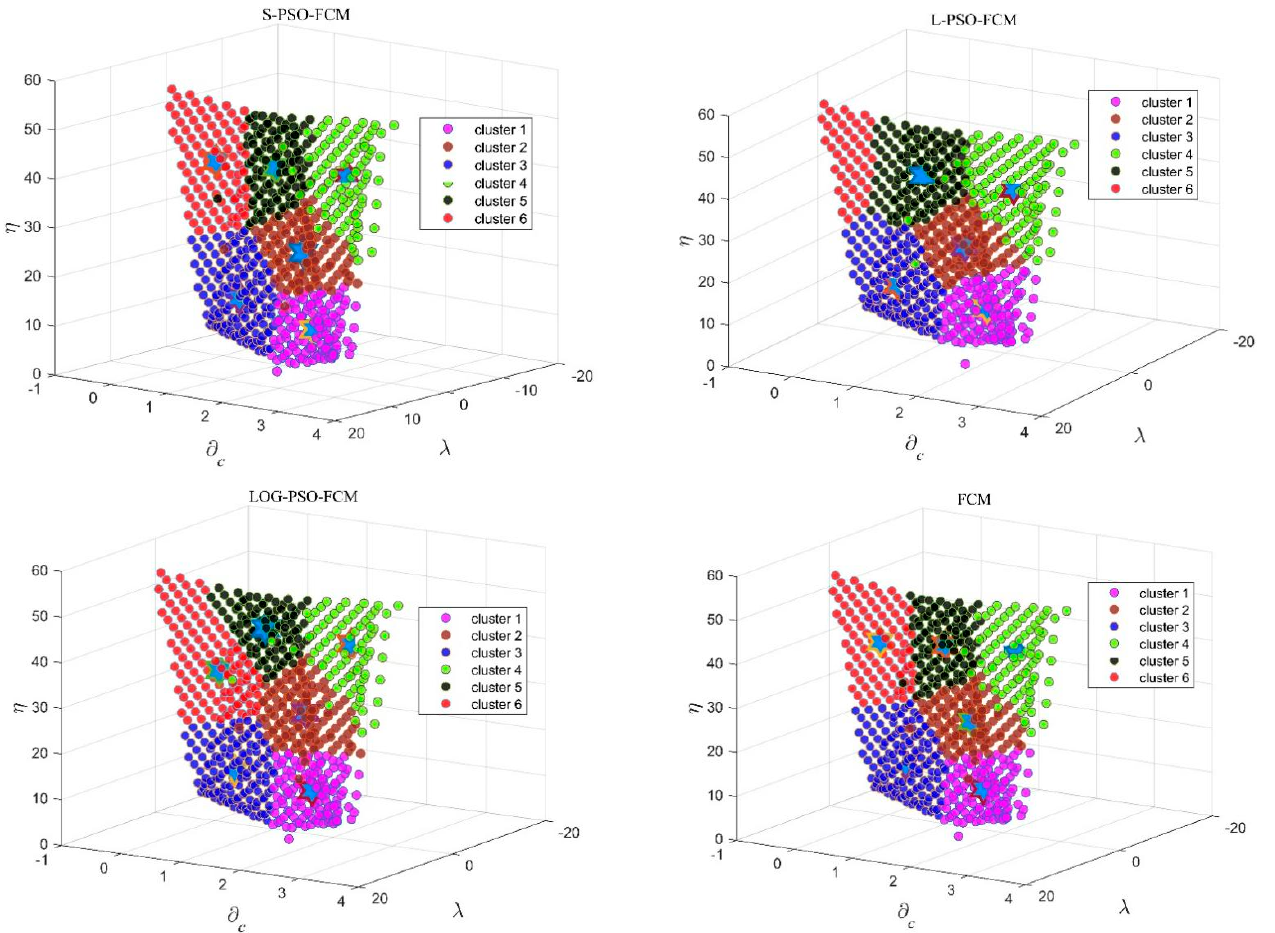
Figure 8. Clustering results with respect to different algorithms. (The data samples in different classes and the corresponding cluster centers are shown. The existing differences in Table 4 will be embodied through this figure—not very fiercely though. The overall clustering results are very close).